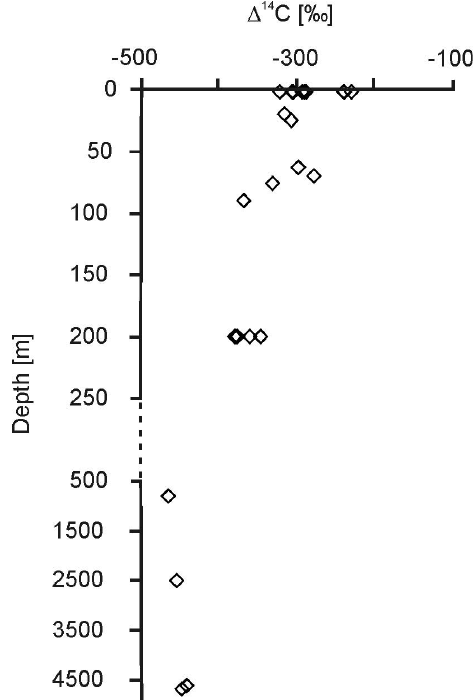
Fig. 3. 1 14 C values of marine SPE-DOM from the eastern Atlantic